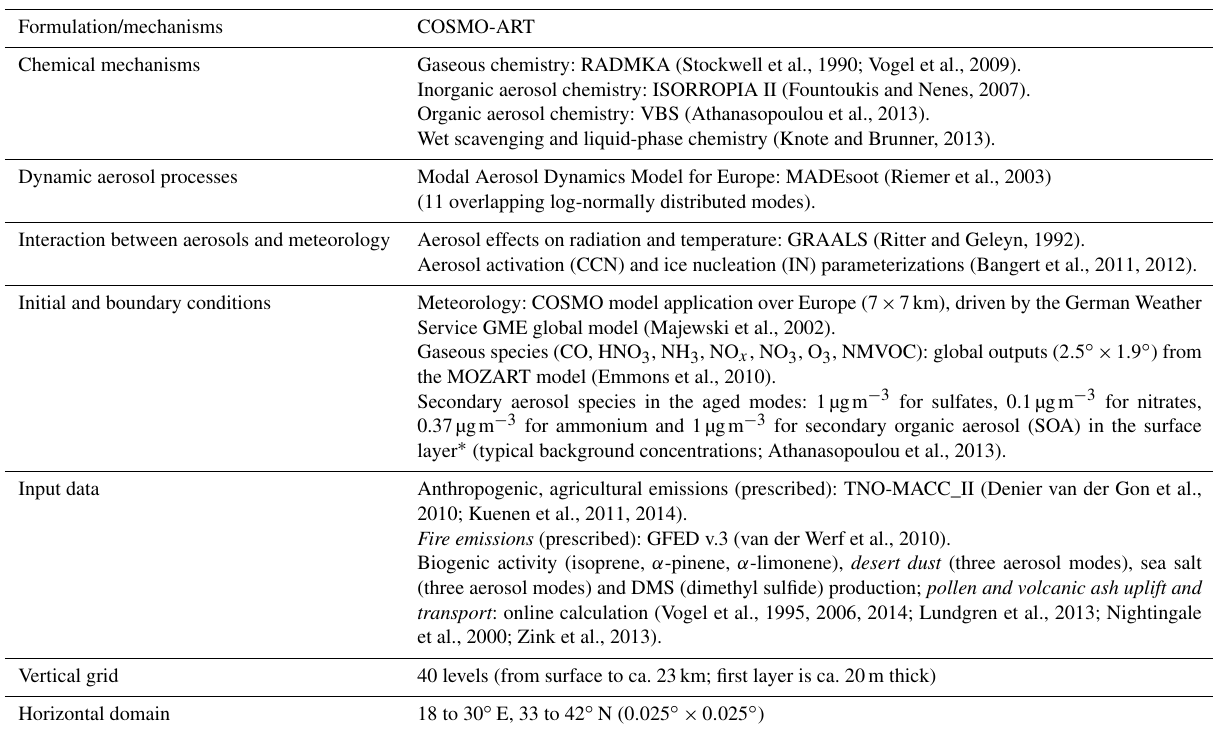
Table 1. Main characteristics of the COSMO-ART configuration and the current model setup. Italic fonts indicate emissions not considered in the current model runs.